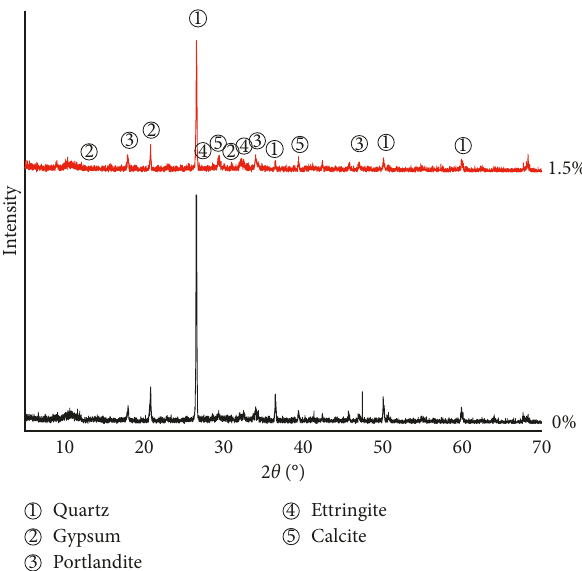
Figure 20: XRD patterns of mortars with different amounts of sodium sulfate at 28d age.